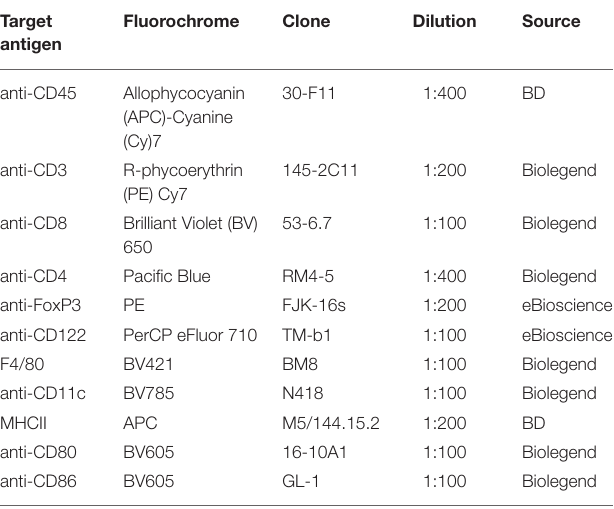
TABLE 1 | Summary of antibodies used in the present